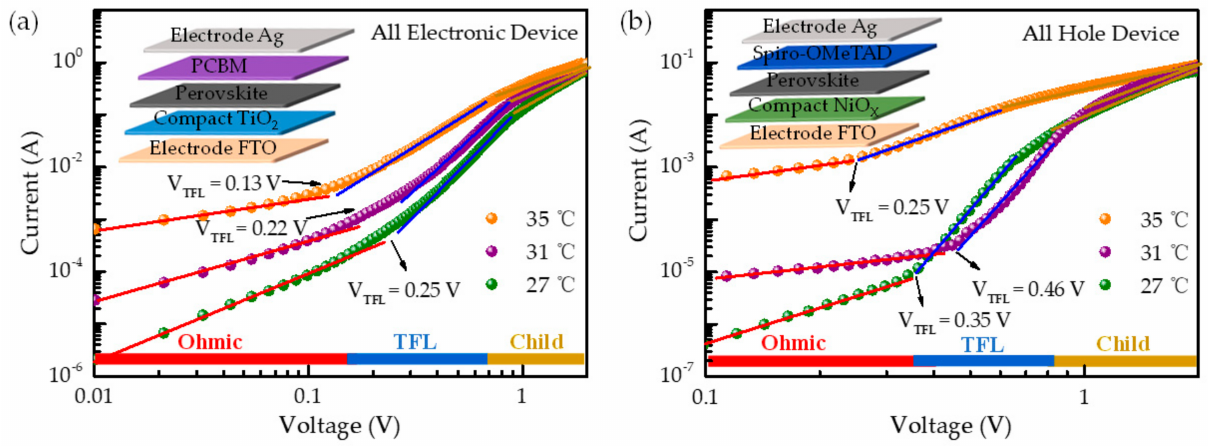
Figure 5. Dark J–V measurement of ( a ) the electron-only and ( b ) the hole-only devices with the perovskite films prepared at different ambient temperatures (inset shows the device